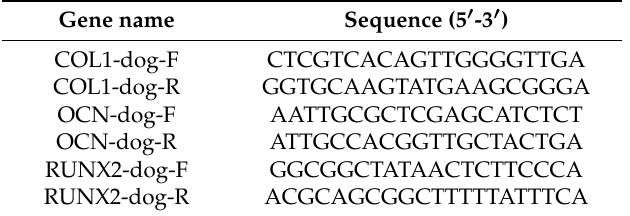
Table 1. Sequences of primers used for reverse transcription polymerase chain reaction